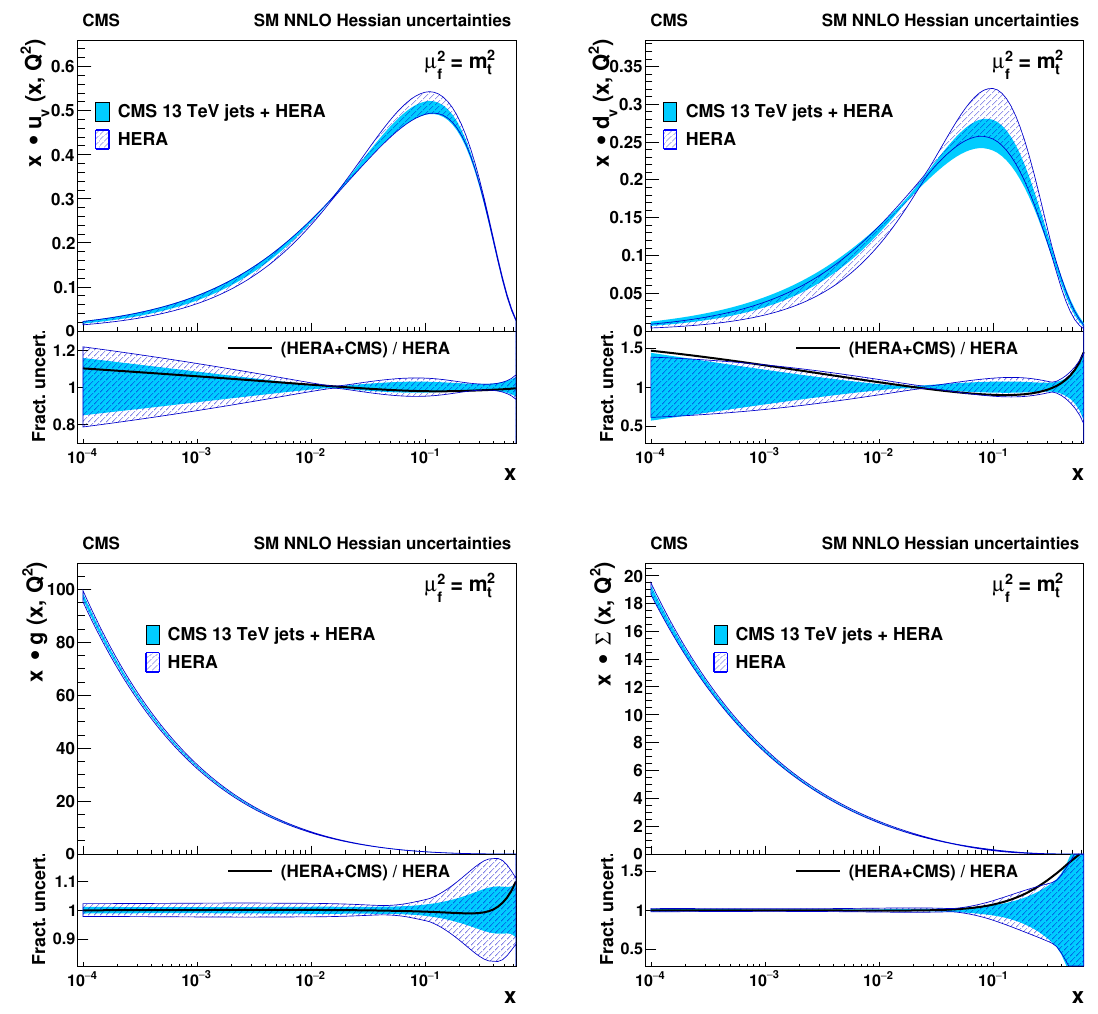
= m . The filled (hatched) band f t